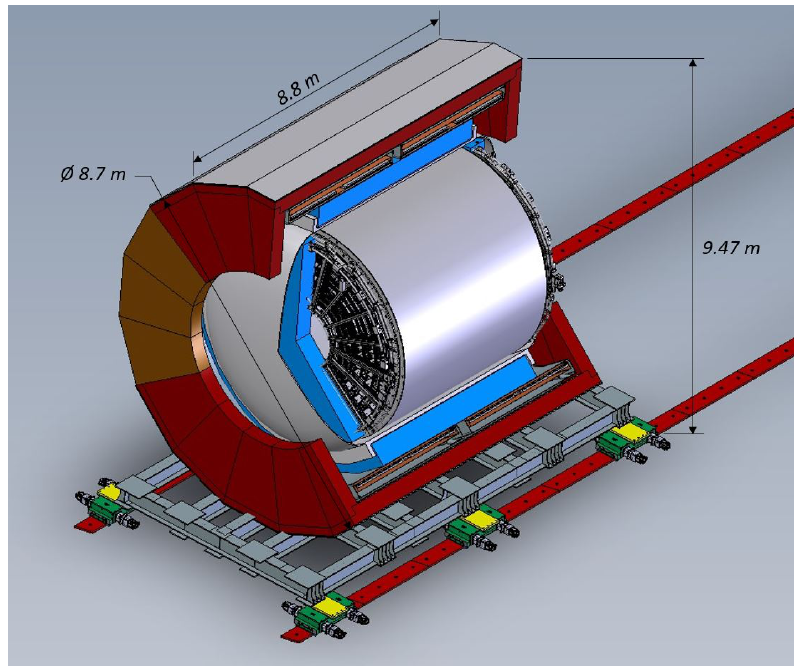
Figure 42. Schematic of ND-GAr showing the HPgTPC, its pressure vessel, the ECAL, the magnet, and the return iron. The detectors for the muon-tagging system are not